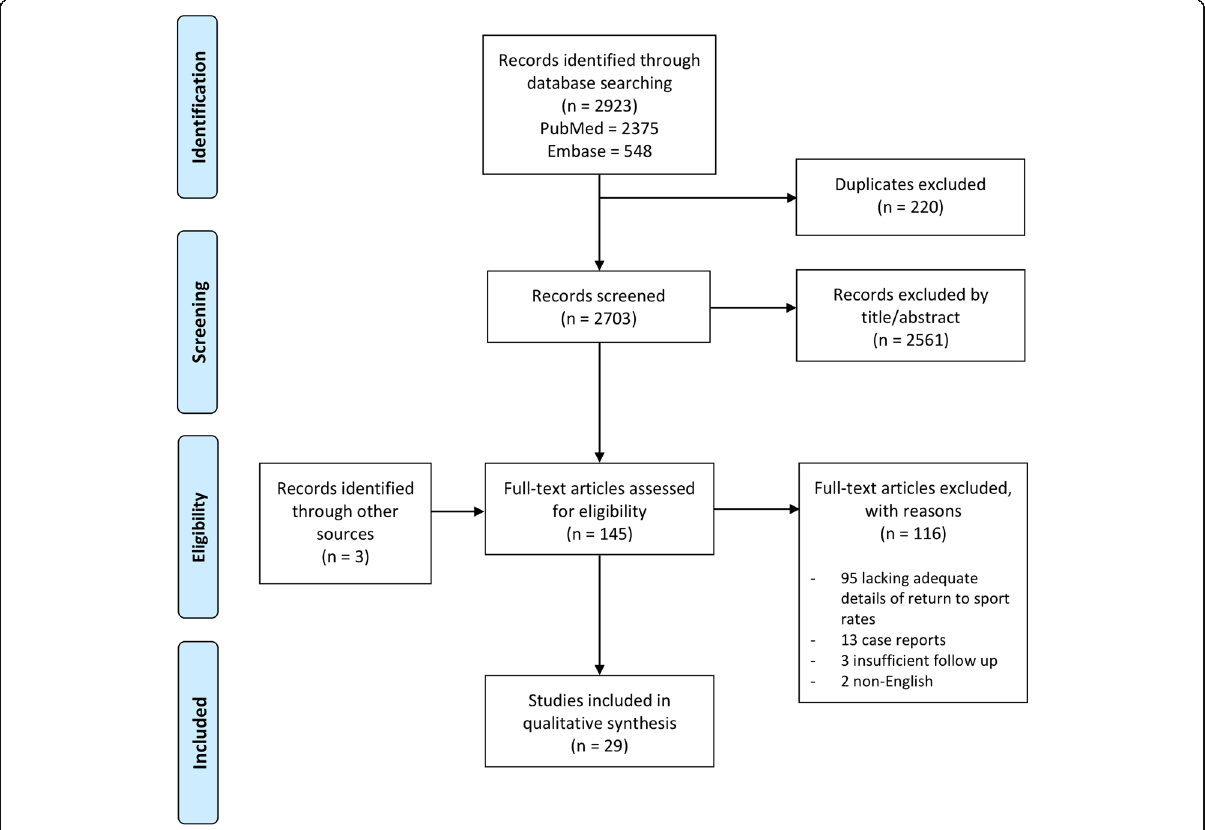
Fig. 1 PRISMA flow diagram showing the study selection